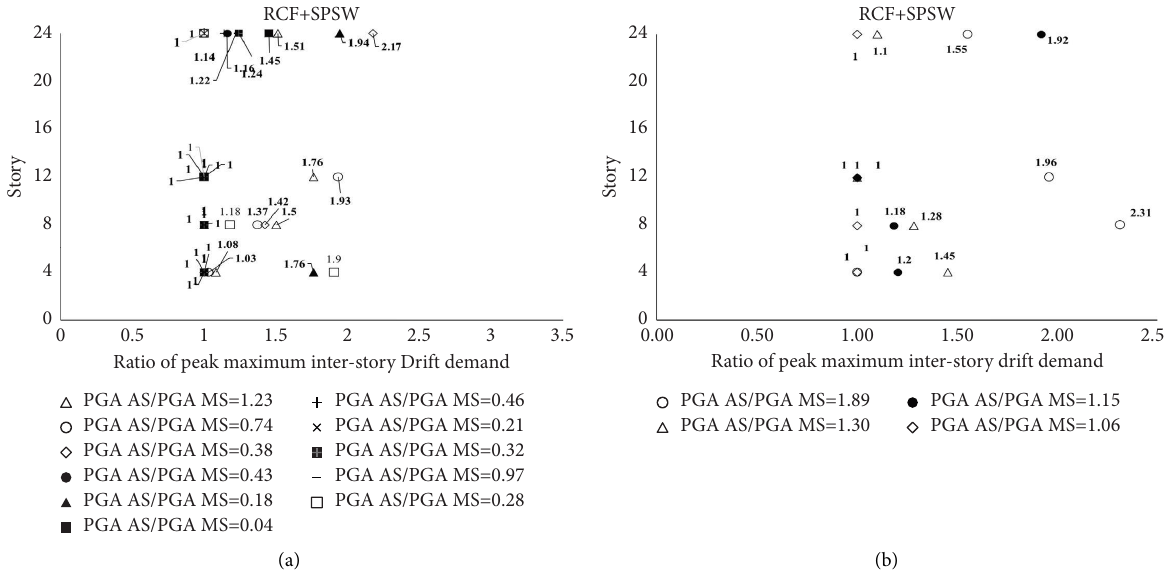
Figure 18: Ratio of the peak maximum interstory drift demand of the real SS of the models to the MS demands under in RCF with SPSW: (a) groups I and II, (b) group